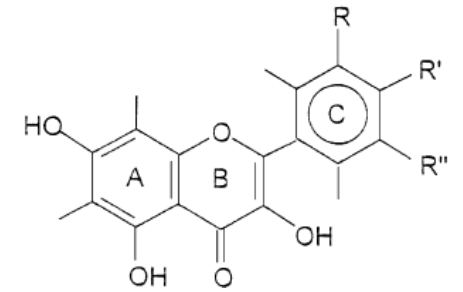
Figure 1. Primary structure of flavonoles; R, R', R'' -